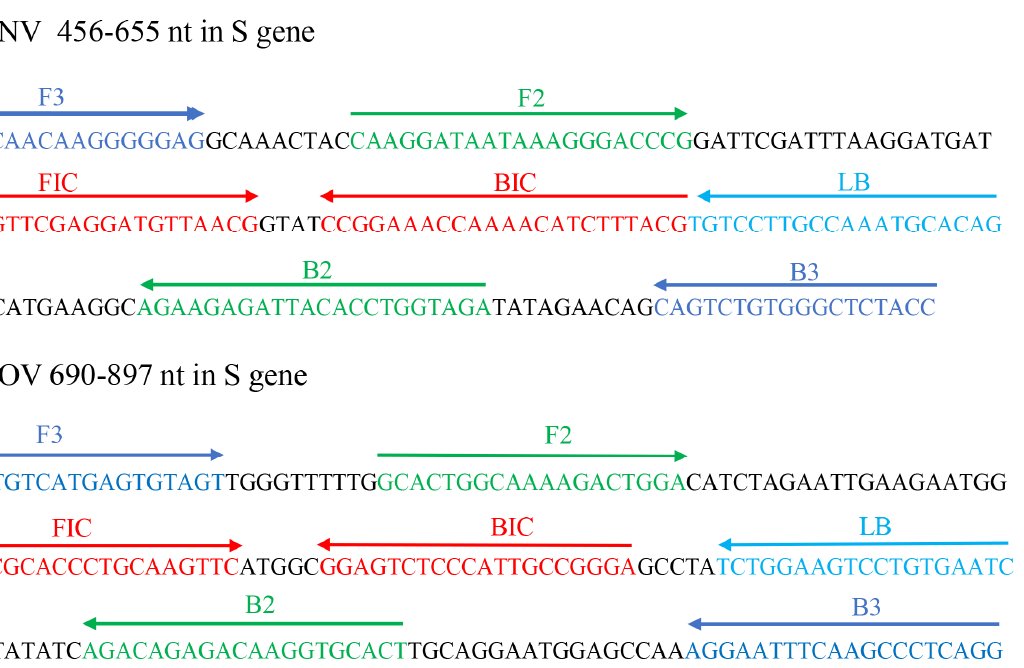
Figure 2. The genomic location of the RT-LAMP primers in the S gene of HTNV and SEOV. The primers include F3, B3 (outer primer), F2, F1c, B2, and B1c (inner primers), and LB (loop primer).